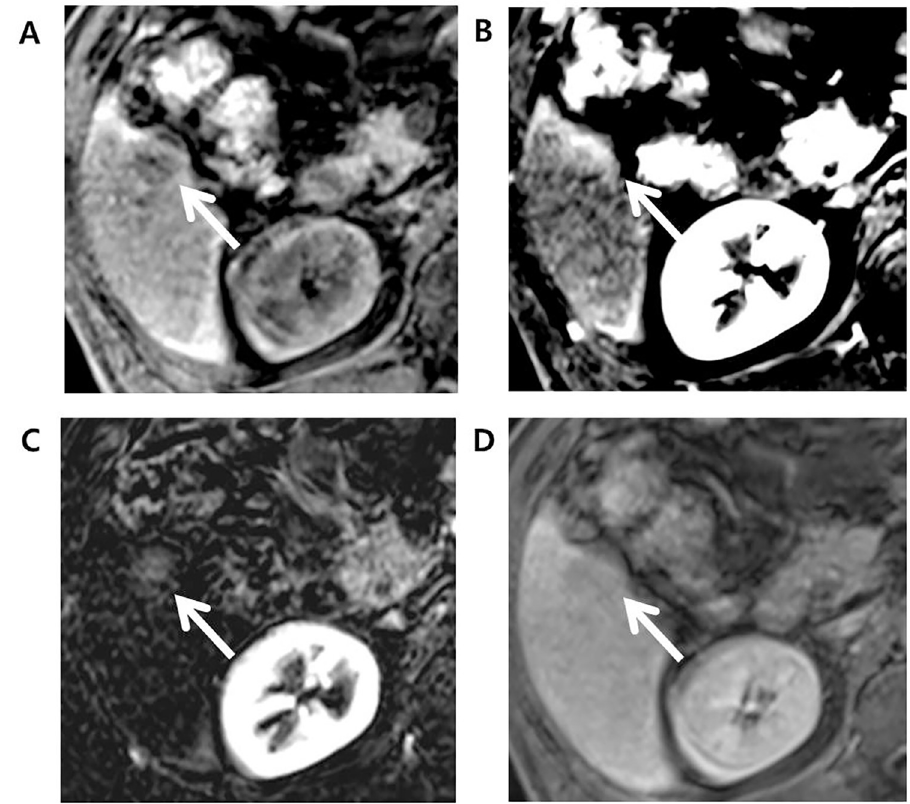
Fig 3. Edmonson grade 1 HCC in 71-year-old male with underlying hepatitis B-viral chronic hepatitis. (A) Axial pre-contrast phase shows a 23mm sized liver mass (arrow) in segment 6 (S6) of the liver. (B) Late arterial phase (AP) shows rim-like arterial hyperenhancement and thus, this observation was categorized as LR-M considering targetoid appearance. (C) Arterial subtraction image, however, shows a global homogeneous enhancement and, with presence of threshold growth, this observation was re-categorized as LR-5. (D) Delayed phase shows hypointensity compared to background liver.